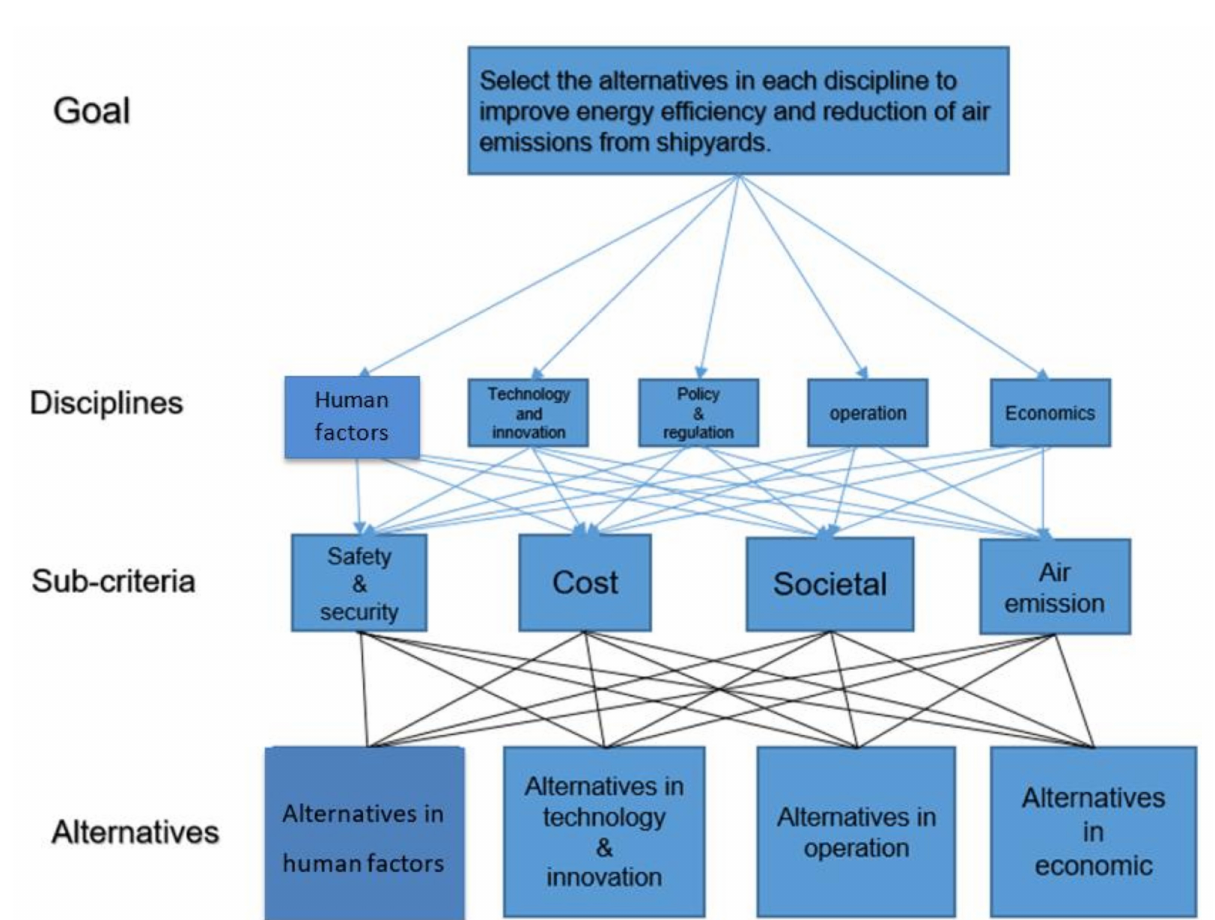
Figure 5. The hierarchical decision framework for selecting options to improve energy efficiency and reduce air emissions from